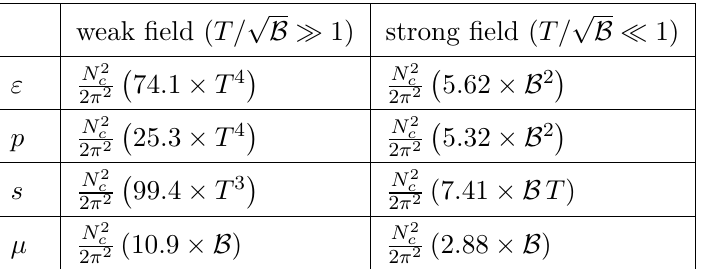
Table 1 . Approximate asymptotic behaviour of the equation of state in weak- and strong-(cid:12)eld limits for (cid:22) (cid:11) = 1 =